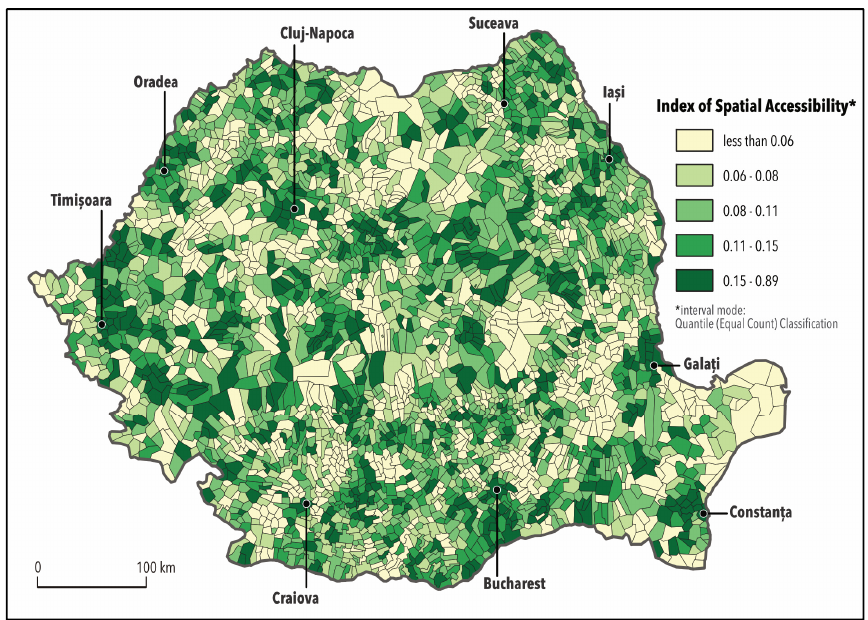
Figure 4. Index of Spatial Accessibility (ISA).